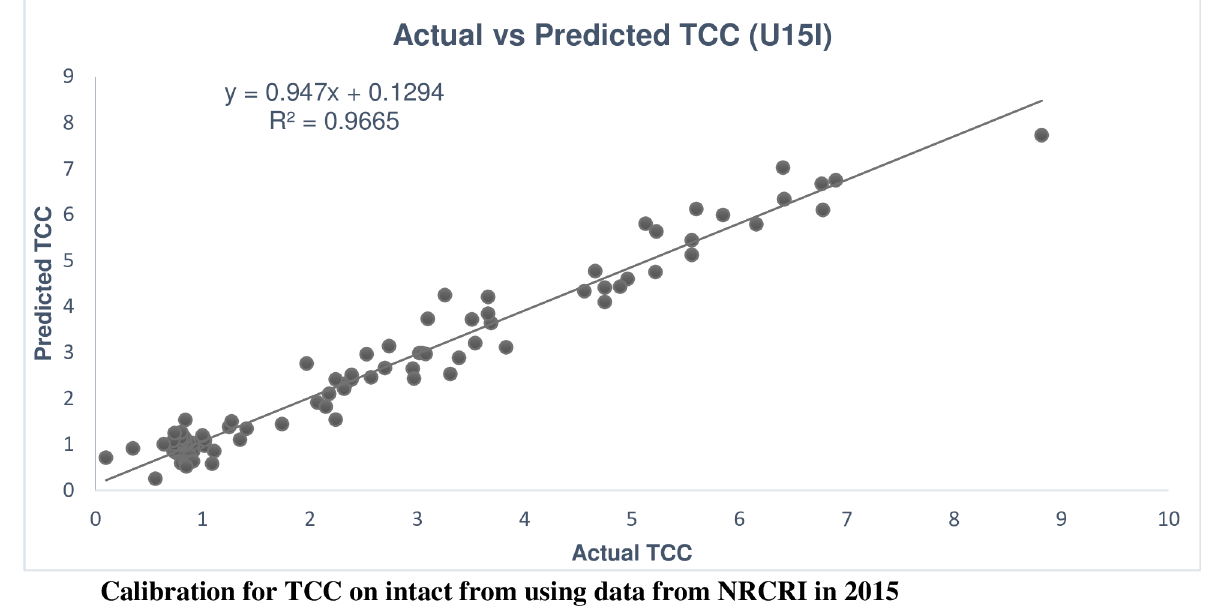
Fig 2. Predicted plotted against observed TCC in the calibration set, intact root samples, NRCRI 2015.